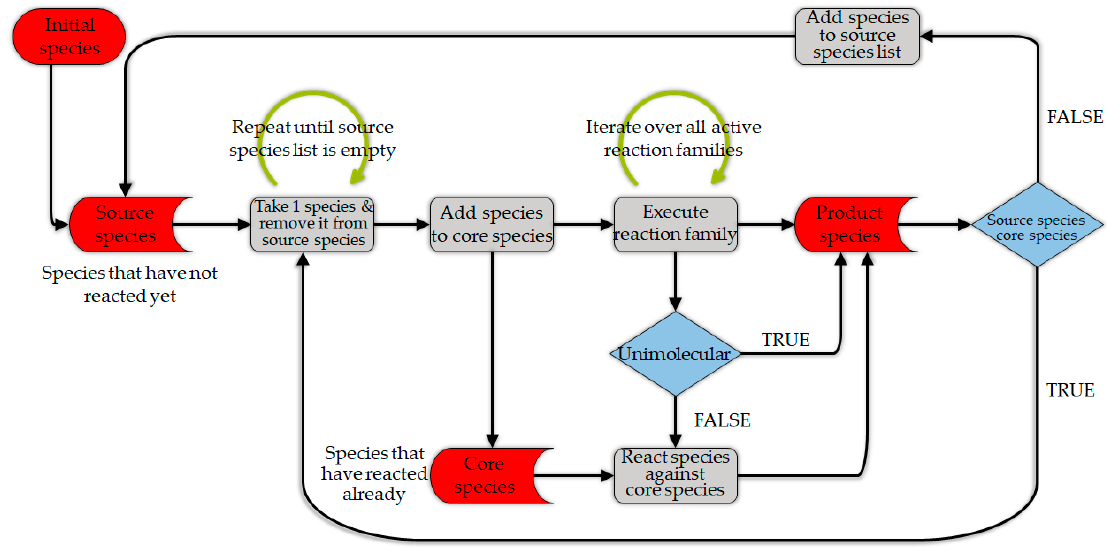
Figure 11. The algorithm of Genesys to create a reaction network by applying the pre-defined reaction families on the unreacted molecules (Redrawn from Ref. [135]). Reprinted from Chemical Engineering Journal, Vol. 207–208, Nick M. Vandewiele, Kevin M. Van Geem, Marie-Françoise Reyniers, Guy B. Marin, Genesys: Kinetic model construction using chemo-informatics, Pages No. 526–538, Copyright (2012), with permission from Elsevier.